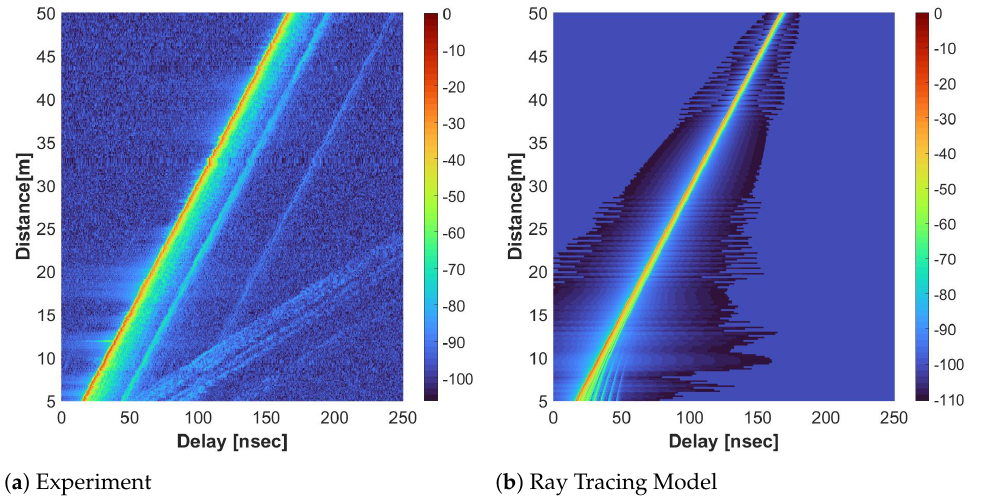
Figure 9. 3D plot of the PDP throughout the tunnel.